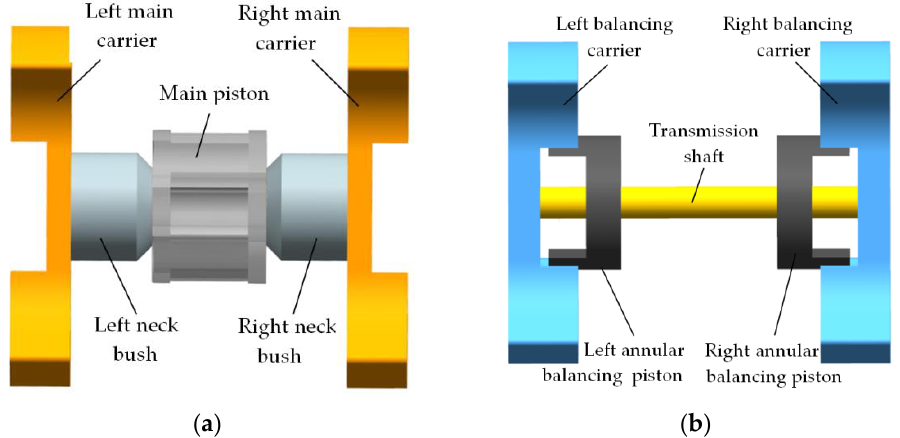
Figure 1. Schematic configuration of the 2D piston pump with balancing sets.